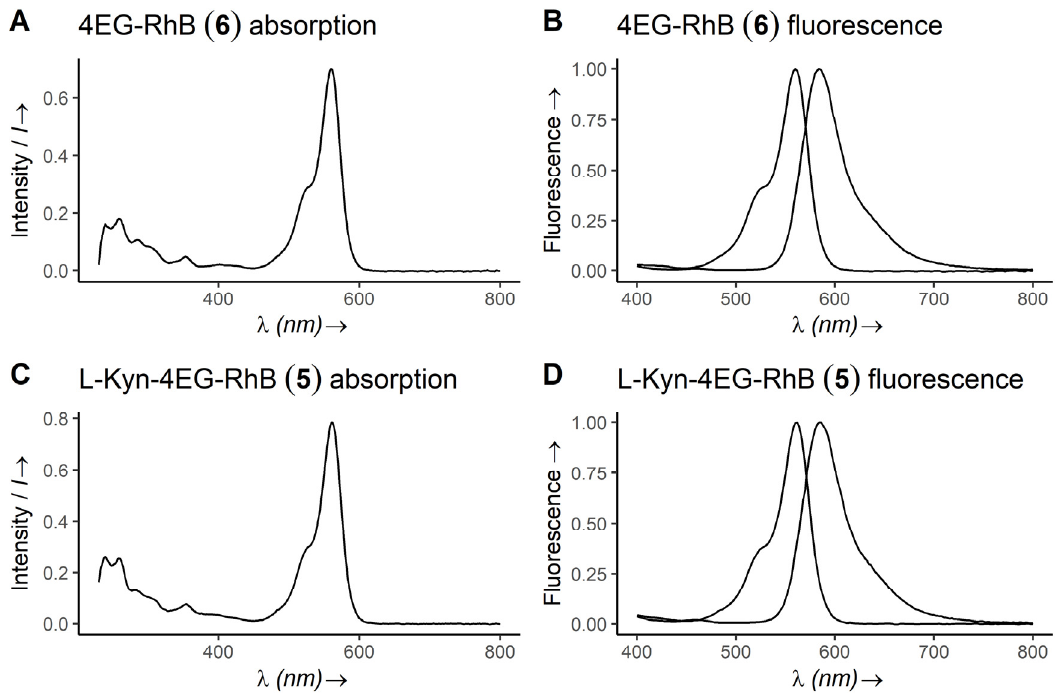
Figure 2. Absorption ( A , C ) and fluorescence ( B , D ) spectra of compounds 5 and 6 , measured in ddH 2 O. Absorption maxima of compounds 5 and 6 are shifted slightly to 560 nm in the comparison at 554 nm for native rhodamine B [42]. Fluorescence maxima are 586